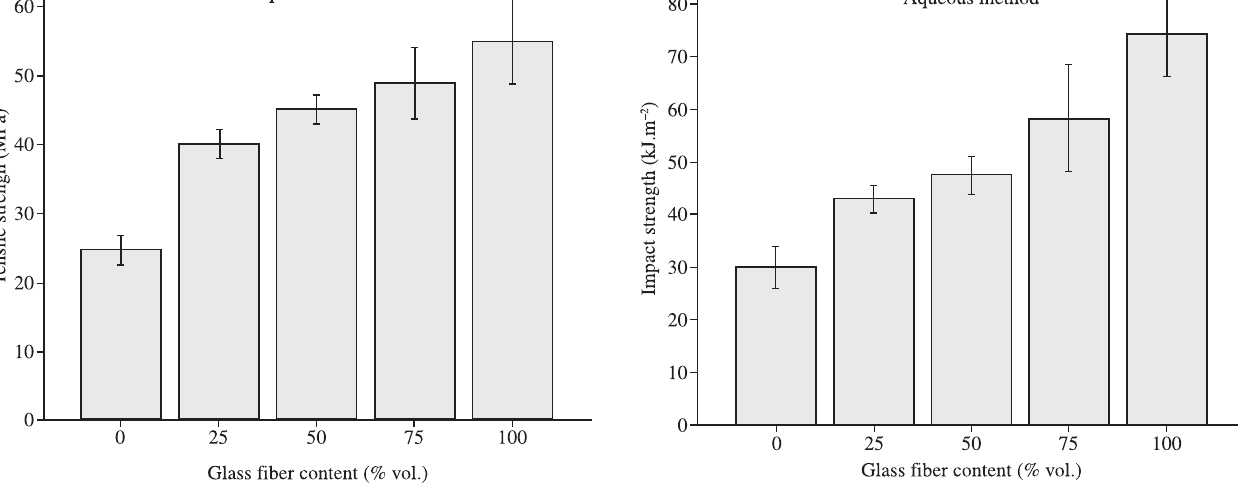
Figure 4. Impact strength of the composites in relation to the glass fiber content of the mats – Aqueous